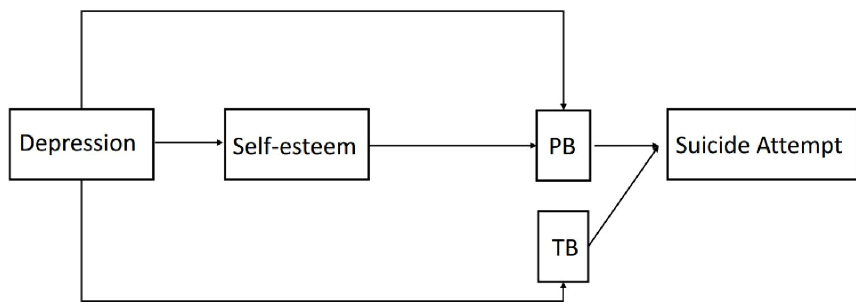
Figure 4. The alternative model that self-esteem just predicts PB according to ITS.